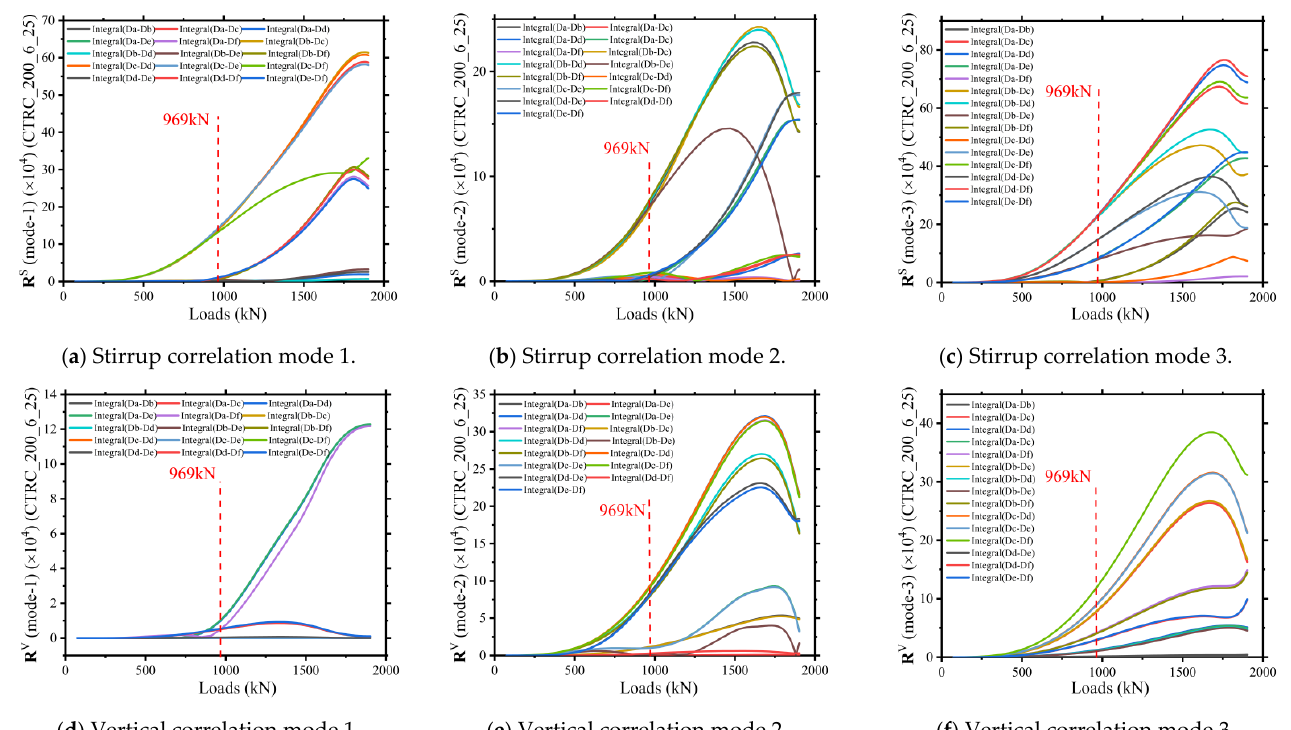
Figure 9. Stirrup bar characteristic pairs of CTRC_200_6_25.